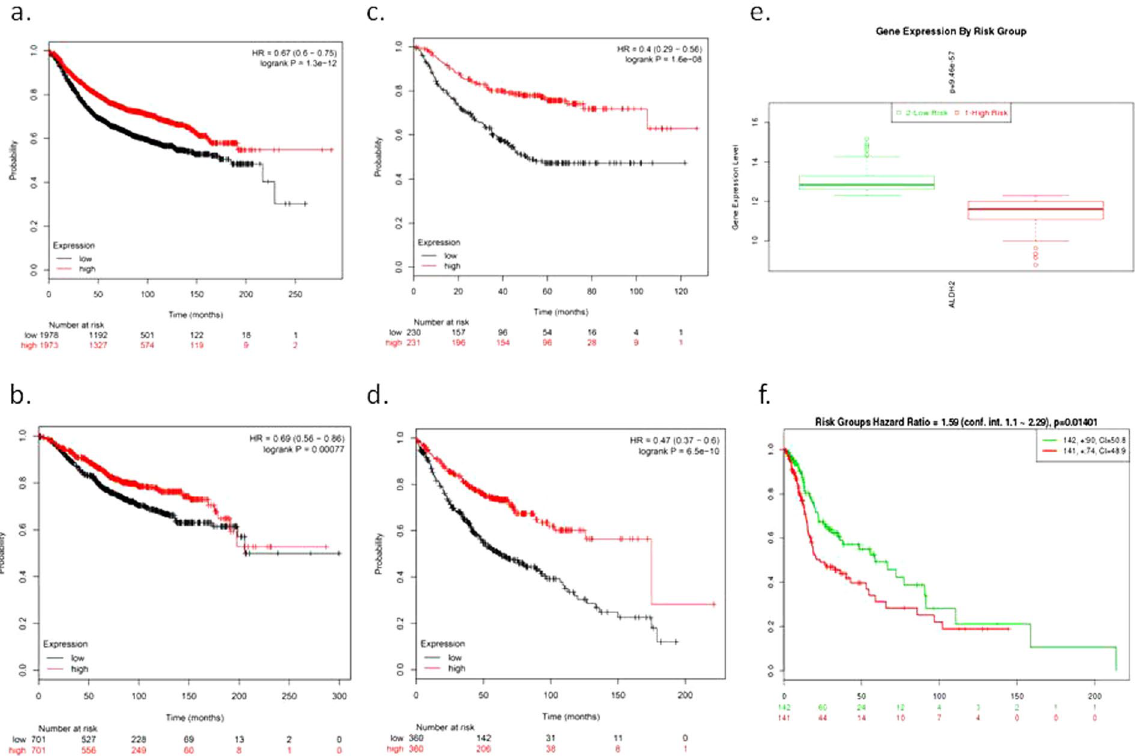
Figure 4. Survival curves of high vs. low ALDH2 expression in patients with cancer. ( a ) Kaplan-Meier relapse- free survival for patients with breast cancer. ( b ) Kaplan-Meier overall survival for patients with breast cancer. ( c ) Kaplan-Meier time-to-progression for patients with lung adenocarcinoma. ( d ) Kaplan-Meier overall survival for patients with lung adenocarcinoma. Red: High; Black: Low. HR: Hazard ratio. ( e ) The high expression